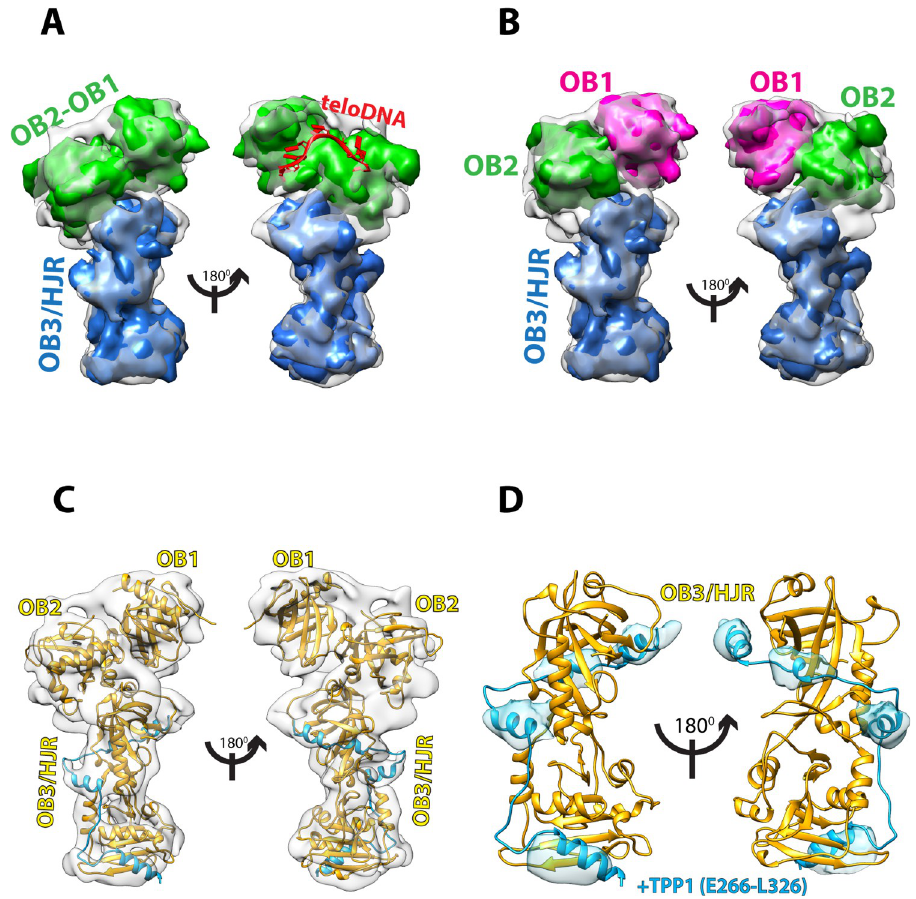
Fig 3. Cryo-EM map at 7.9 Å resolution of POT1 bound by TPP1 (E266-L326) with fitted crystal structures. ( A ) Simulated 8 Å maps generated in Chimera for known crystal structures of POT1 domains were fitted into the 7.9 Å cryo-EM map to find structural complementarity. Simulated map for the crystal structure of POT1 (OB1-OB2) (PDB ID: 1XJV) (green) after removal of the ssDNA ligand fits the top half of the map, while simulated map for crystal structure of POT1 (OB3/HJR) complexed to the POT1-binding domain (PBD) of TPP1 (E266-L326) (PDB ID: 5UN7) (blue) fits the bottom half of the map. Placement of ssDNA ligand from PDB ID: 1XJV onto map depicts the location of the DNA-binding groove (red). ( B ) Simulated 8 Å maps for OB1 (magenta) and OB2 (green) demonstrate that improved complementarity of POT1 (OB1-OB2) can be achieved by fitting the OB1 and OB2 domains separately. ( C ) Cartoon representation of the structure of full-length POT1 (yellow) bound by the PBD of TPP1 (blue) which interacts with the OB3/HJR domain of POT1, fitted into the 7.9 Å cryo-EM map. ( D ) Fit of crystal structure of POT1 (OB3/ HJR) complexed to the PBD of TPP1 shows that the α -helices of TPP1 (blue) overlap perfectly with four complimentary densities in the map (blue